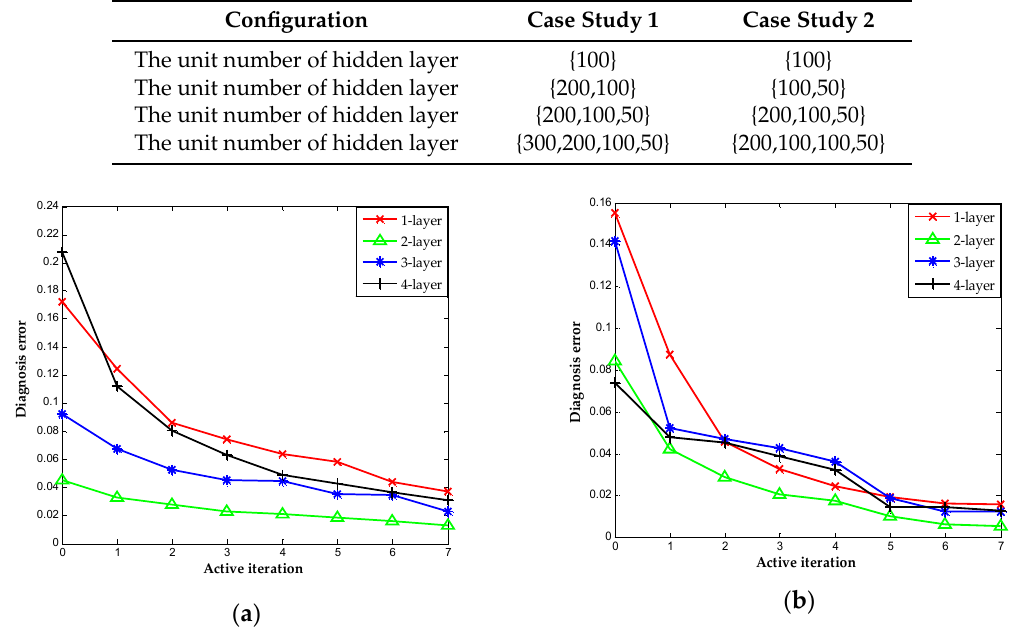
Figure 15. Classification results obtained by AL-DNN with multiple layers: ( a ) UCI (University of California Irvine) dataset; and ( b ) TE dataset.